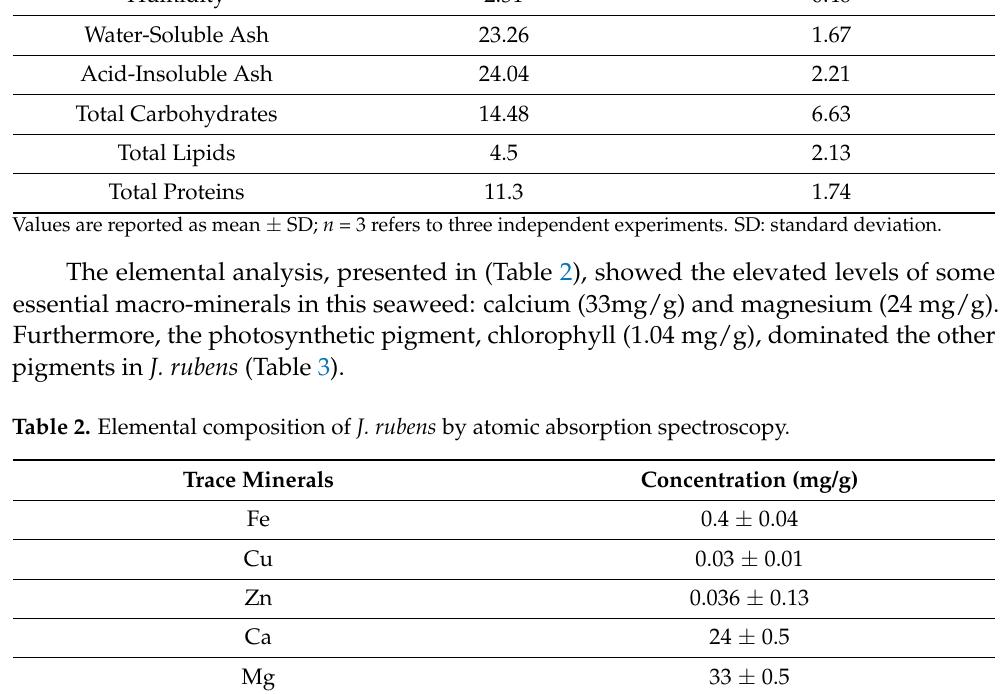
Table 3. Quantitative analysis of the photosynthetic pigments present in J. rubens